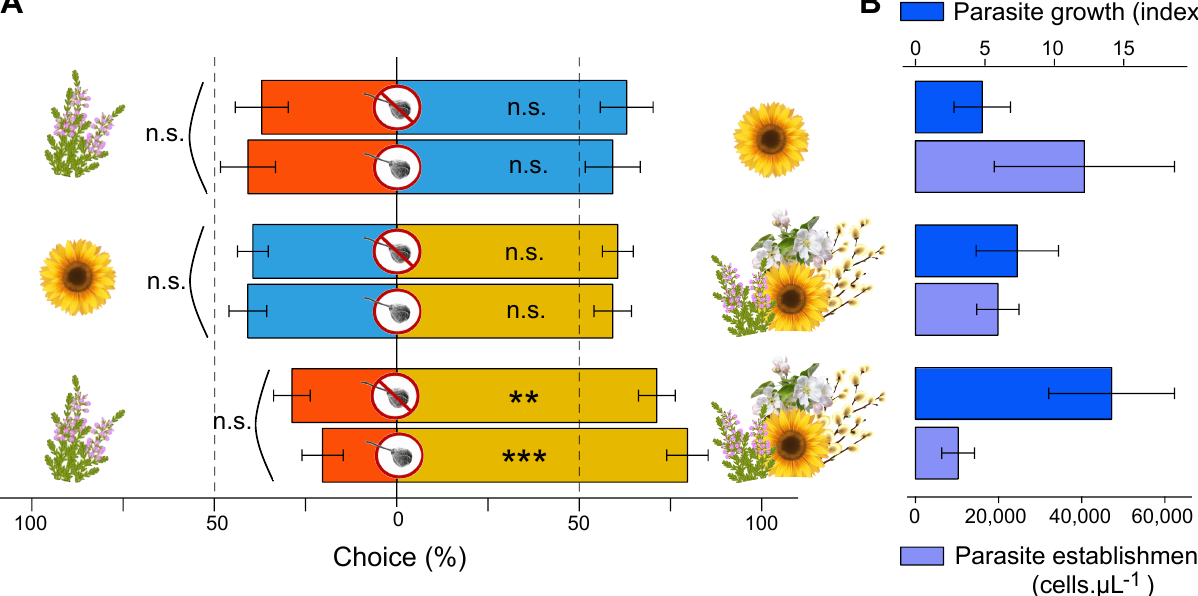
Figure 8. Self-medication behaviour in B. terrestris microcolonies. ( A ) Pollen preference across treatments (i.e., choice between two different pollen species in each treatment), and ( B ) effects of treatments on parasite establishment (i.e., three days after inoculation) and growth (n.s., p > 0.05; **, p < 0.01; ***, p <